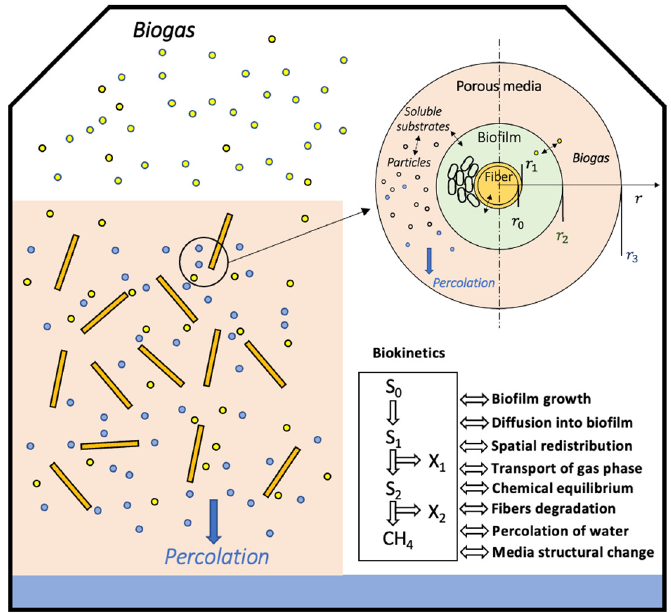
Figure 1. Multiscale simulation of a SSAD leach-bed reactor.